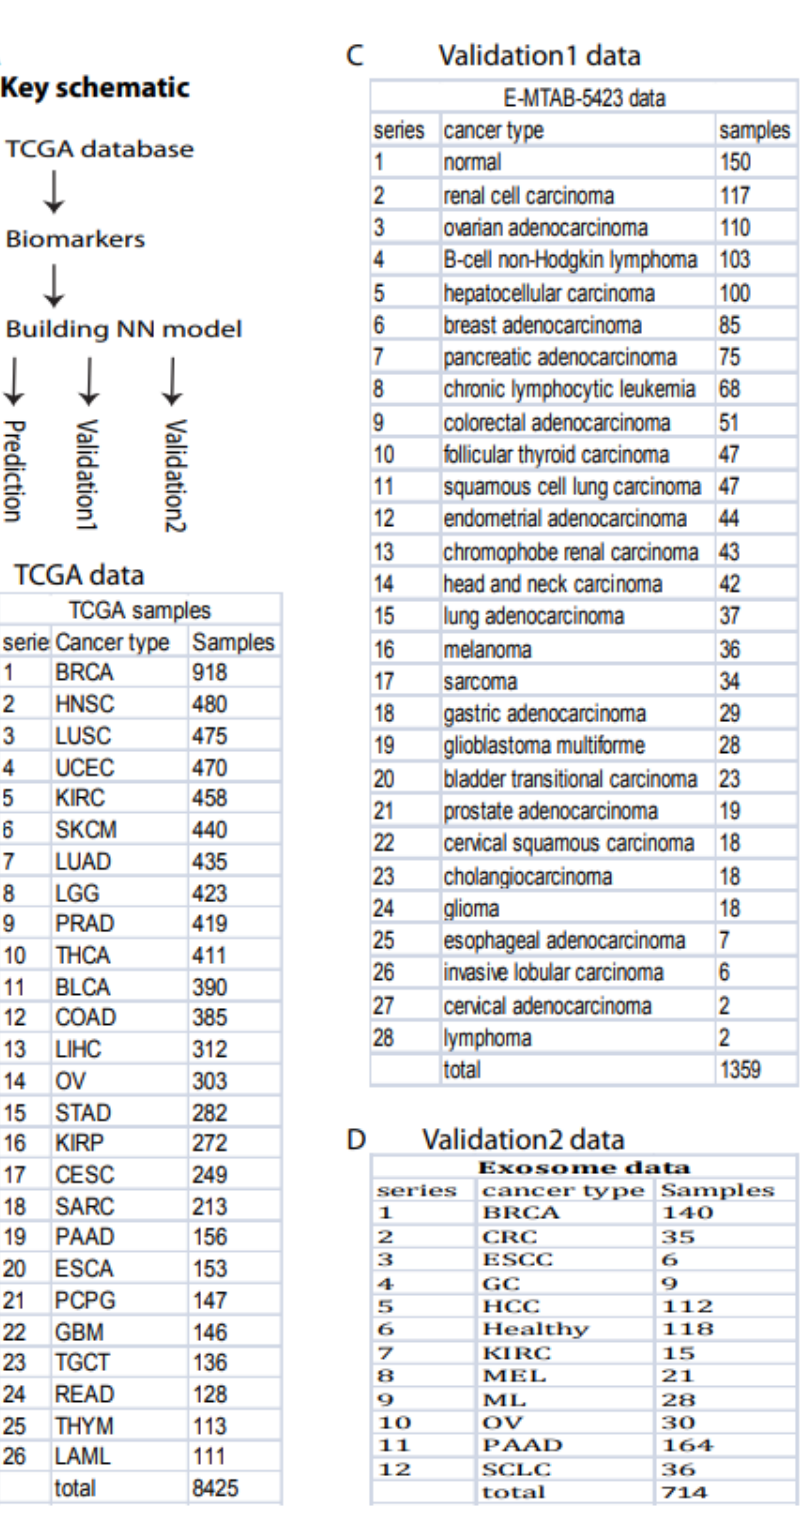
Figure 1. Overall project schematic and samples. ( A ) Key schematic workflow. ( B ) TCGA data included 26 cancer types and 8425 samples. ( C ) Validation data set 1 included 28 cancer types and 1359 samples deposited in ArrayExpress (#E-MTAB-5423). ( D ) Validation data set 2 contained 12 cancer types and 714 exosome samples downloaded from exoRBaseV2 [34].